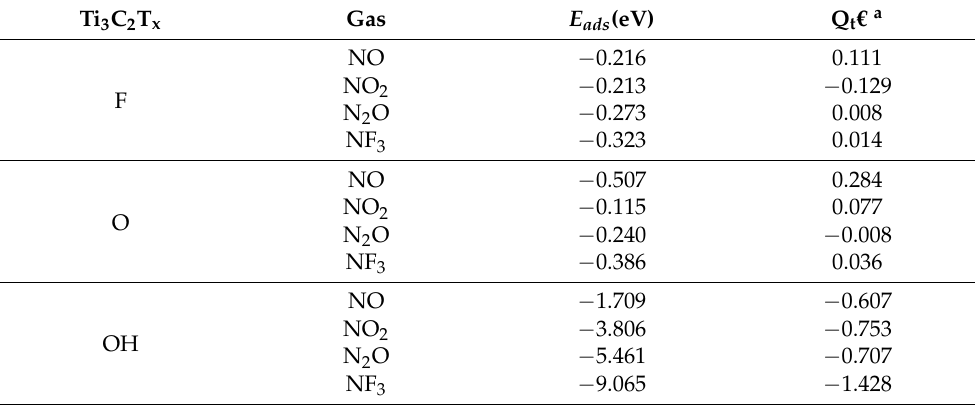
Table 2. Adsorption energy and charge transfer of gas molecules on Ti 3 C 2 T x .